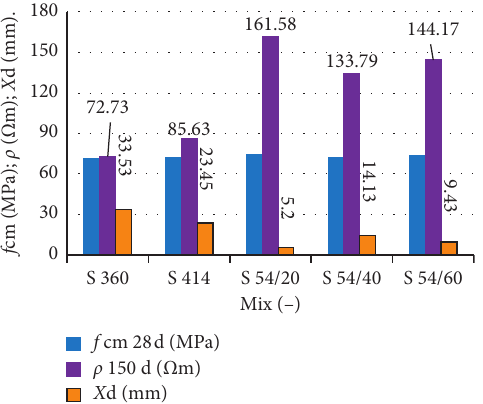
Figure 15: Compression strengths f (cm) at 28 and 150 days.